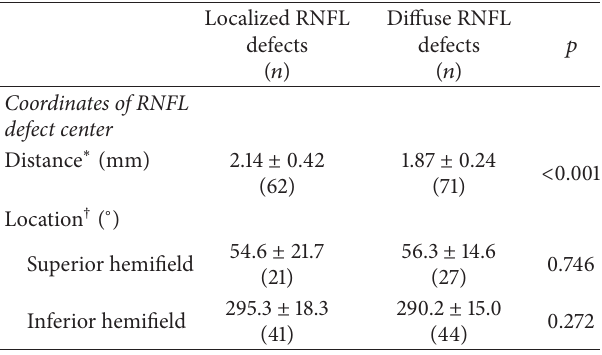
Table 3: Comparison of the centers of RNFL defects between localized and diffuse RNFL defects.